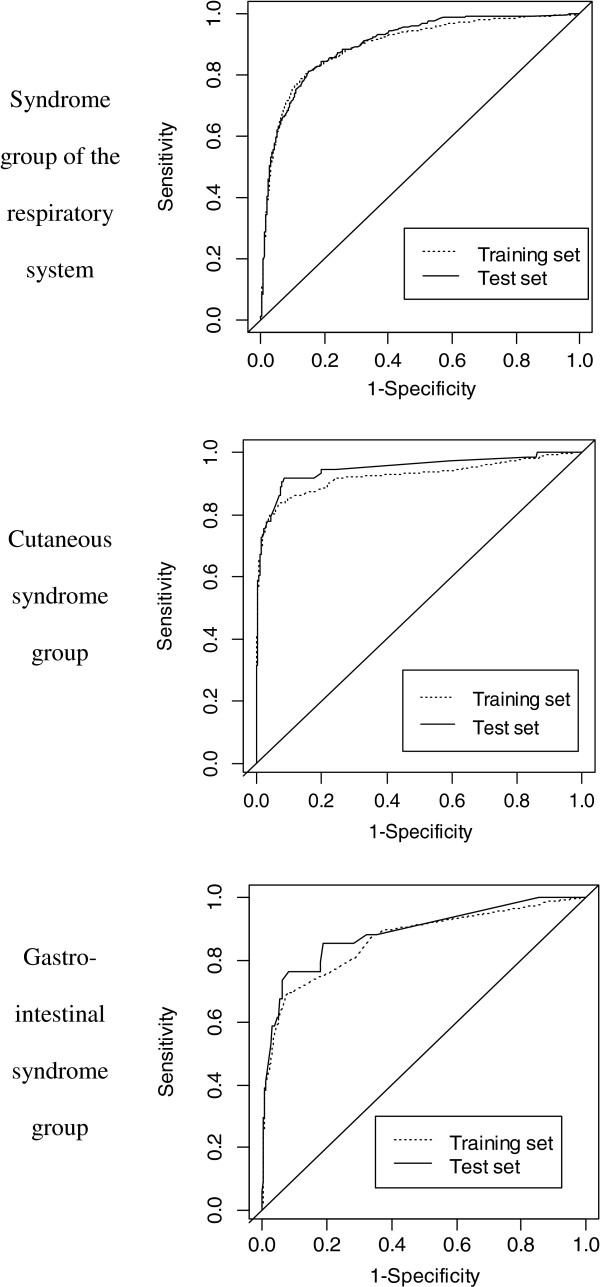
Receiver operating characteristic (ROC) curves for detecting patients with potentially transmissible infectious diseases. ROC curves were built by using each individual probability as the detection threshold of infection (training and test datasets were used separately).